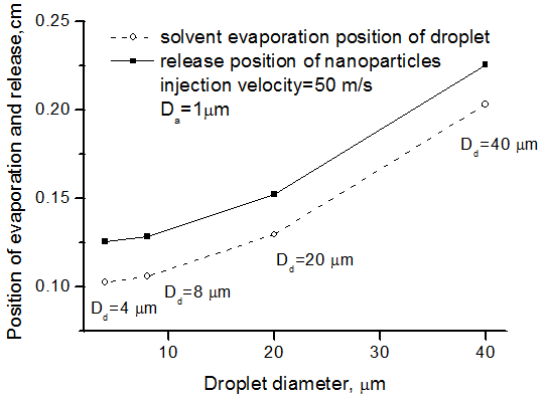
Figure 7. Solvent evaporation position and nanoparticle release position for different droplet diameter.